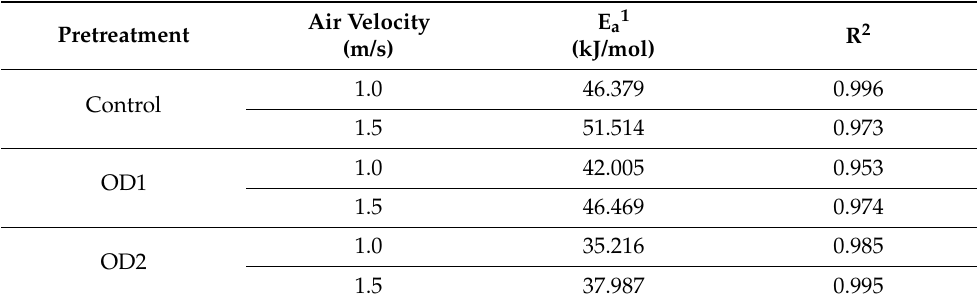
Table 8. The activation energy for the apricot halves during the HAD process.